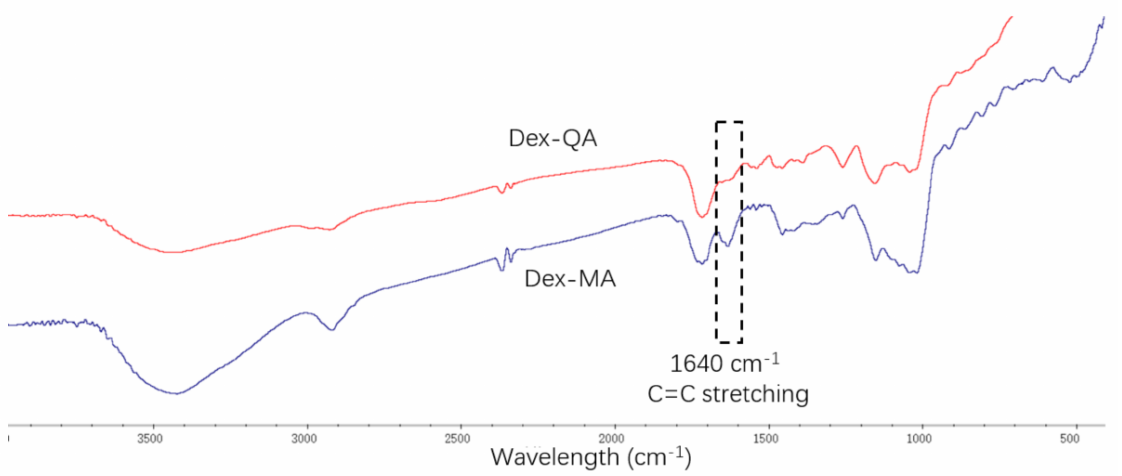
Figure 2. FT-IR spectra of Dex-QA and